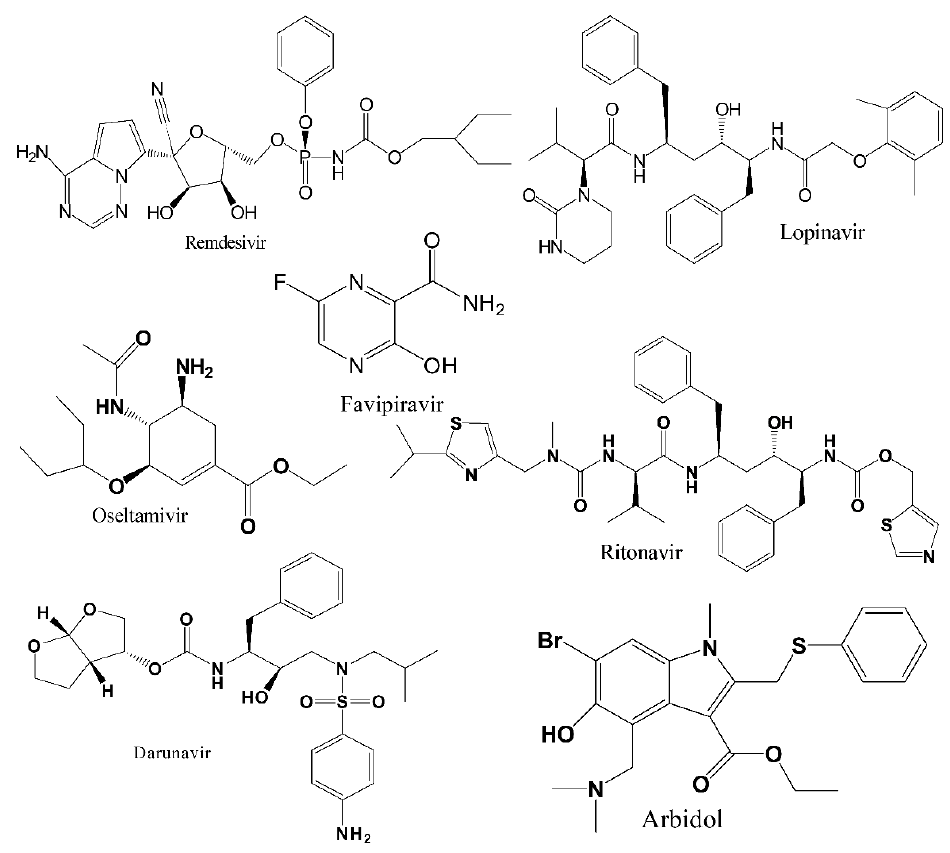
Figure 1. Chemical structures of the selected most promising antiviral drugs against COVID-19.